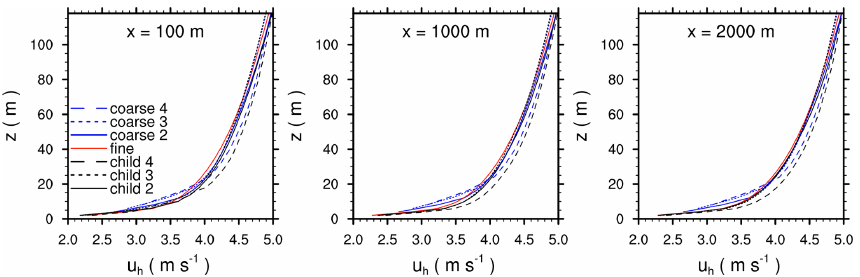
Figure 11. The 2h time-averaged and y -averaged profiles of the horizontal wind speed for the grid-spacing ratio of 2, 3, and 4, taken at different distances downstream of the inflow boundary, indicated by the solid white lines in Fig. 9. In addition, corresponding time-averaged and y -averaged profiles from the fine- and coarse-reference simulations taken at the same locations are